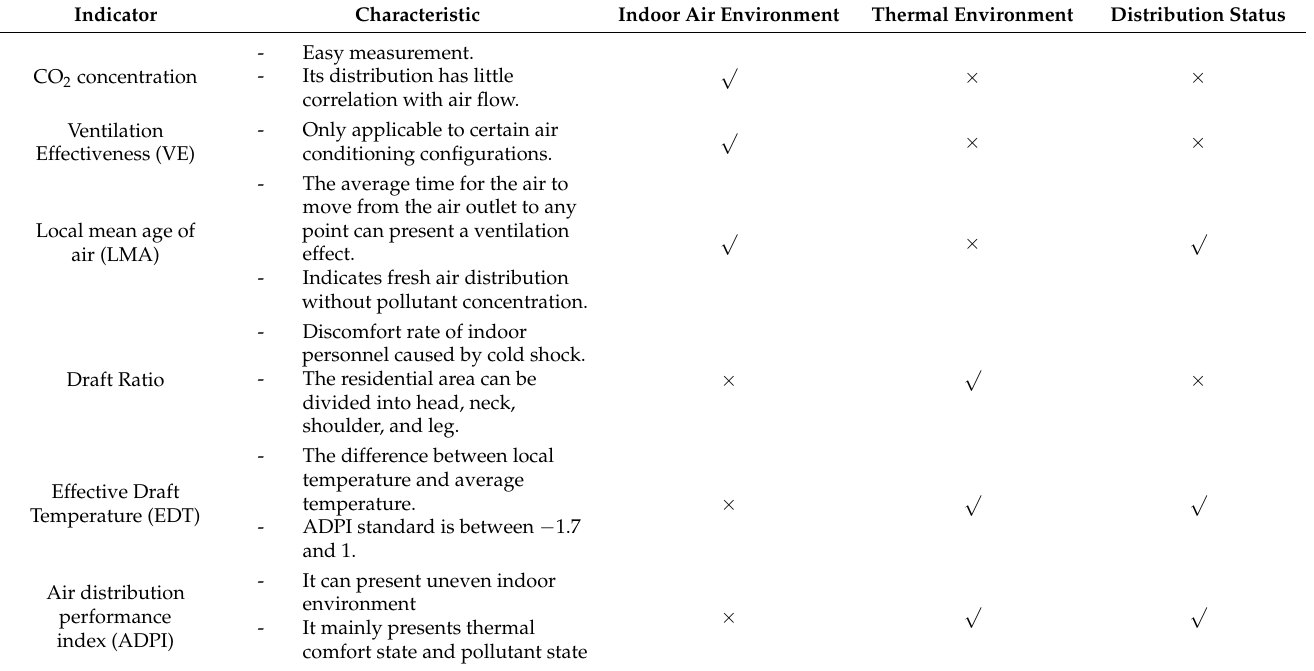
Table 3. Air and thermal environment assessment